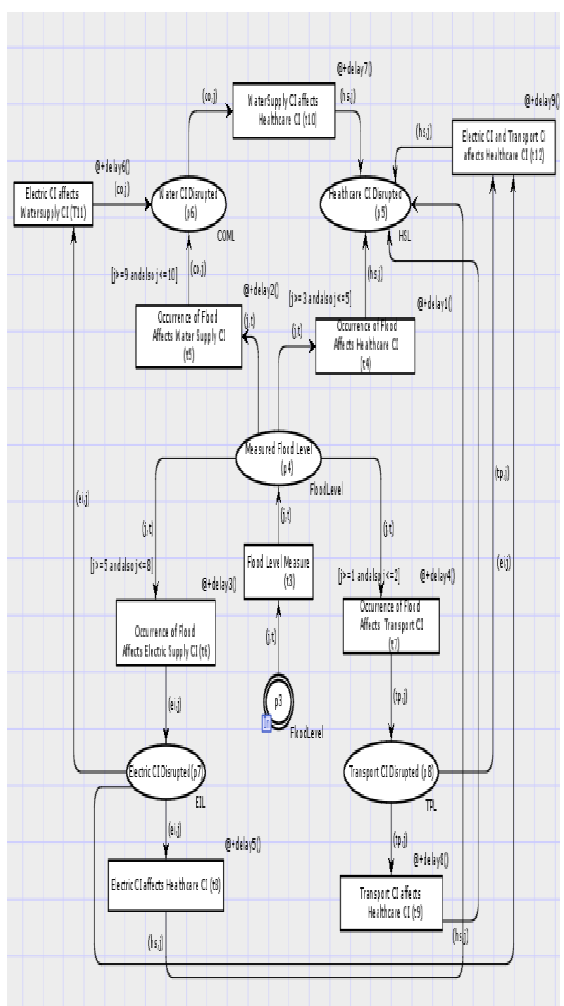
Figure 2.Healthcare CI Interdependency Simulation SCPN.